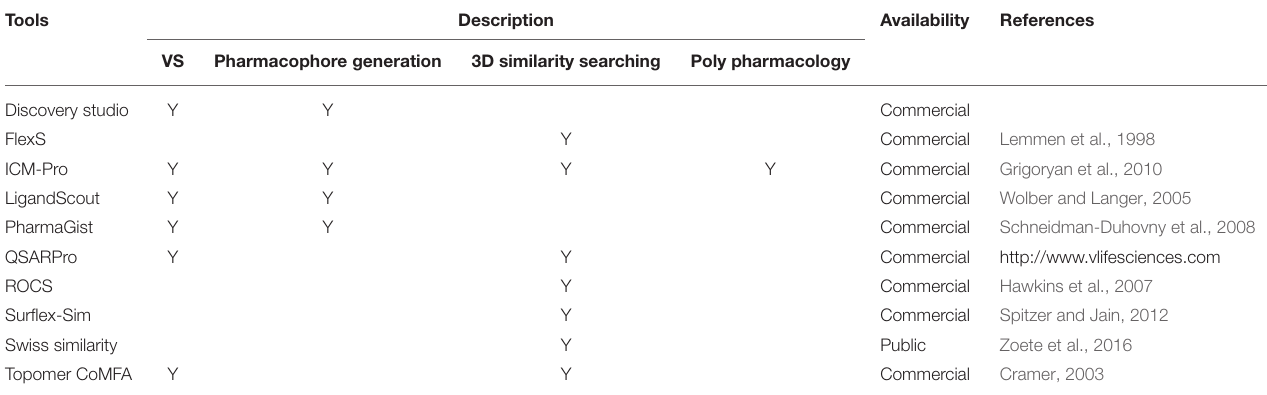
TABLE 4 | Cheminformatics tools for ligand-based drug discovery.